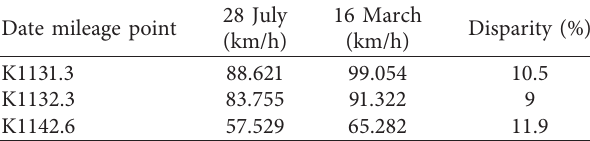
Table 1: Average speed under the